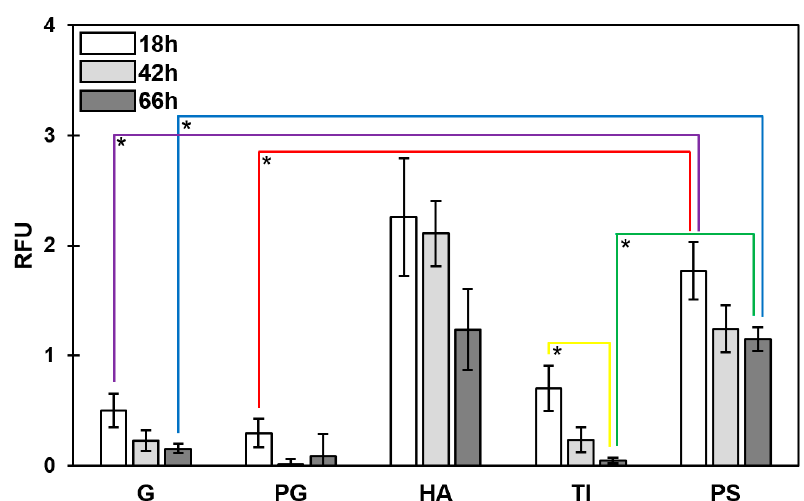
Figure 3. Wheat germ agglutinin Alexa Fluor ® 488 conjugate-based quantification of poly- N -acetyl- β -(1-6)-glucosamine (PNAG) in S. aureus ATCC 25923. Differences in PNAG contents (expressed as relative fluorescence units (RFUs)) were assessed for a single material between different time points, and for a fixed time point between the different materials, using one-way ANOVA comparisons and Games–Howell post-tests for blank-corrected data points. *, significant difference ( p < 0.05). Error bars denote the standard error of the mean (SEM) ( n = 2). G, borosilicate glass; PG, plexiglass; HA, hydroxyapatite; TI, titanium; PS, polystyrene.